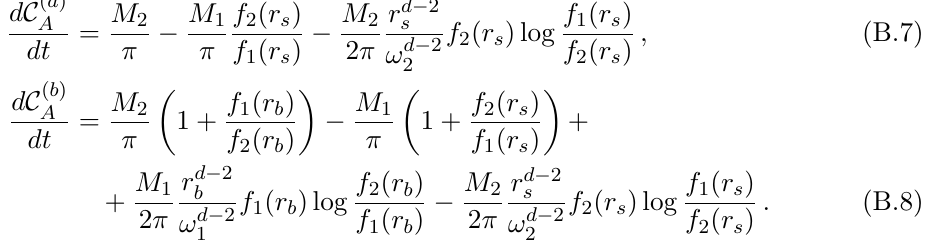
(represented by the horizontal